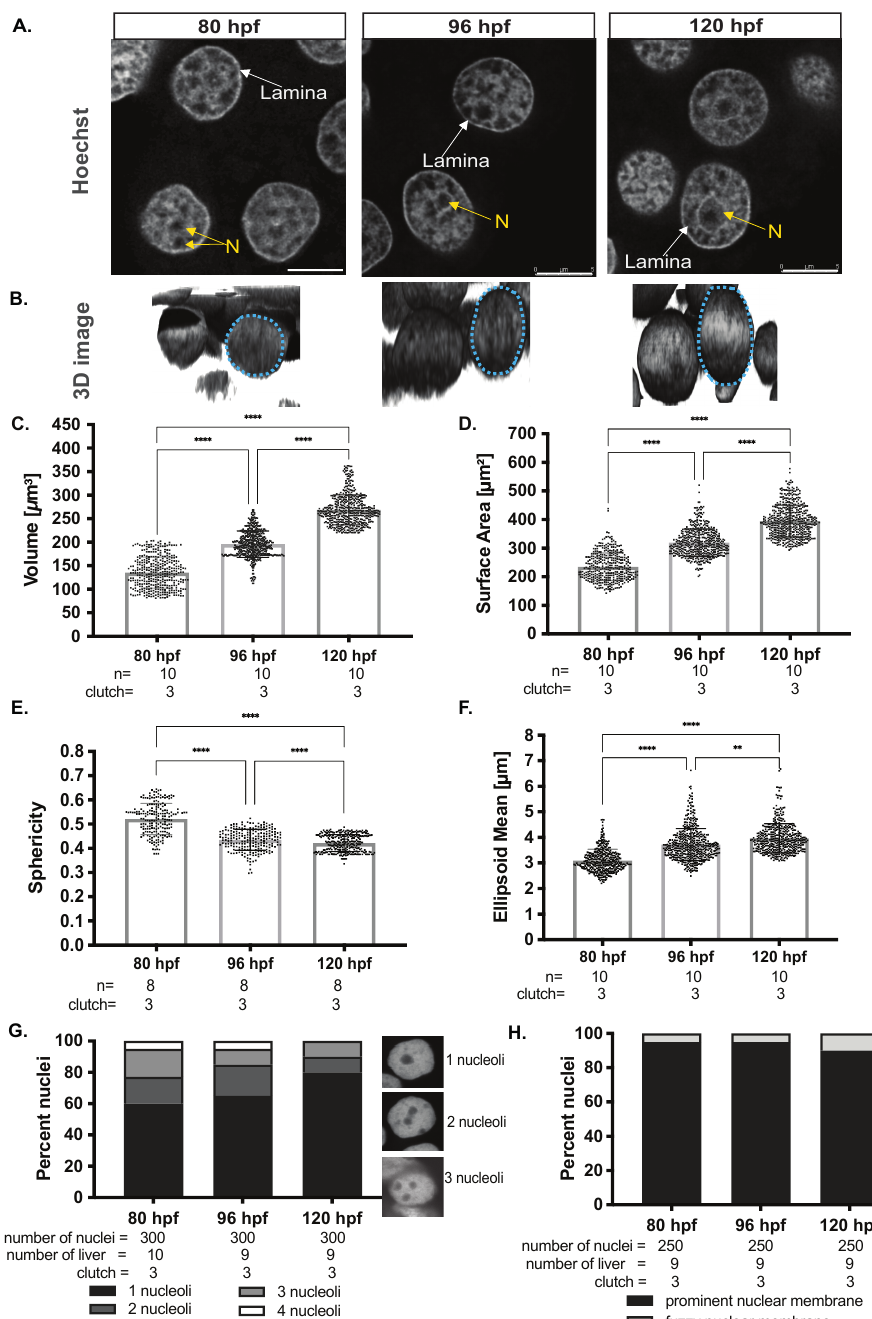
Figure 1. Hepatocyte nuclei increase in size, become elliptical and reduce nucleoli number during hepatic outgrowth. ( A ). Representative confocal images of Hoechst-stained hepatocytes from larvae at 80, 96, and 120 hpf. Regions depleted of Hoechst staining represent euchromatic regions, strong Hoechst foci represent heterochromatin. Yellow N indicates nucleolus; White arrows point to examples of the prominent nuclear lamina. Scale bar: 5 µ m ( B ). 3D reconstructions of Z-stacks of Hoechst-stained hepatocyte nuclei at 80, 96, and 120 hpf display changes in size and shape as the embryo ages. Morphological measurements obtained from hepatocyte nuclei were analyzed using Las-X software for volume ( C ), surface area ( D ), sphericity ( E ), and ellipsoid mean ( F ). Each dot on the graph represents an individual nucleus, and the horizontal represents the median Hepatocyte nuclei were scored for the number of nucleoli per hepatocyte ( G ) and the presence of normal nuclear lamina observed as a rim around the nucleus by Hoechst staining ( H ). All measurements except sphericity were obtained by automated measurements in LasX software, while the sphericity was calculated based on surface area and volume measurements. All analyses were performed on larvae from 3 clutches, with minimum of 3 livers analyzed per clutch. ** p < 0.005, **** p < 0.00005. L–nuclear lamina, N-nucleoli. Magnification: 63 × , 4 × zoom, Scale bar: 5 µ